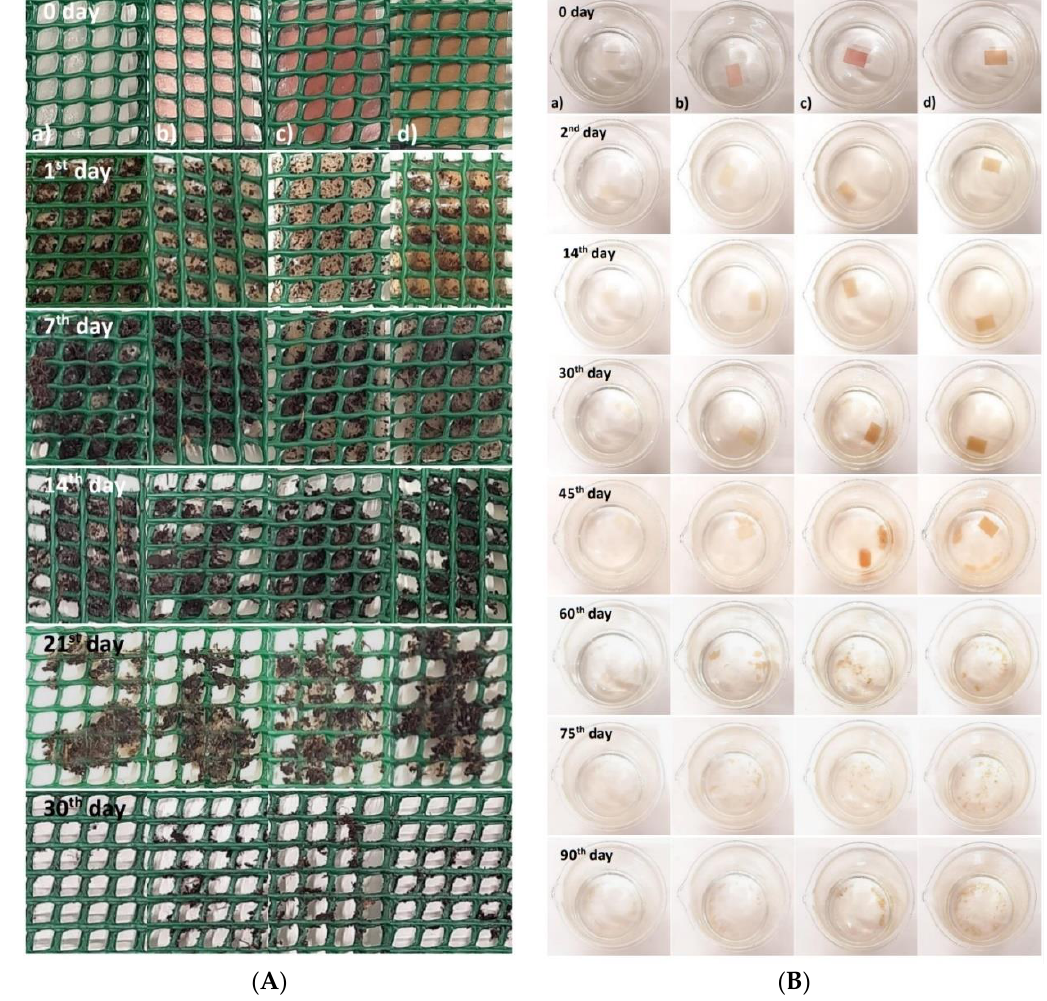
Figure 2. ( A ) Biodegradation test in soil; ( B ) biodegradation test in seawater: ( a ) pectin film (control), ( b ) film with raspberry extract, ( c ) film with blackberry extract, and ( d ) films with blueberry extract.